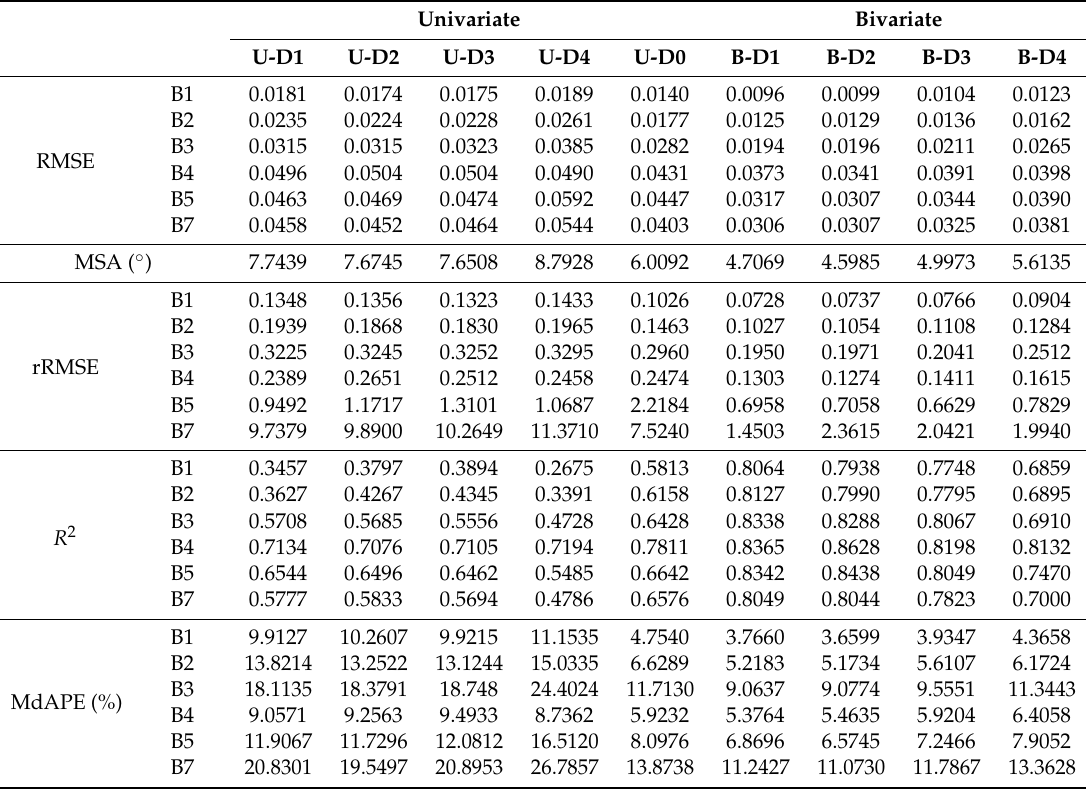
Table 4. Statistical indices of tested cases of R3 (dense